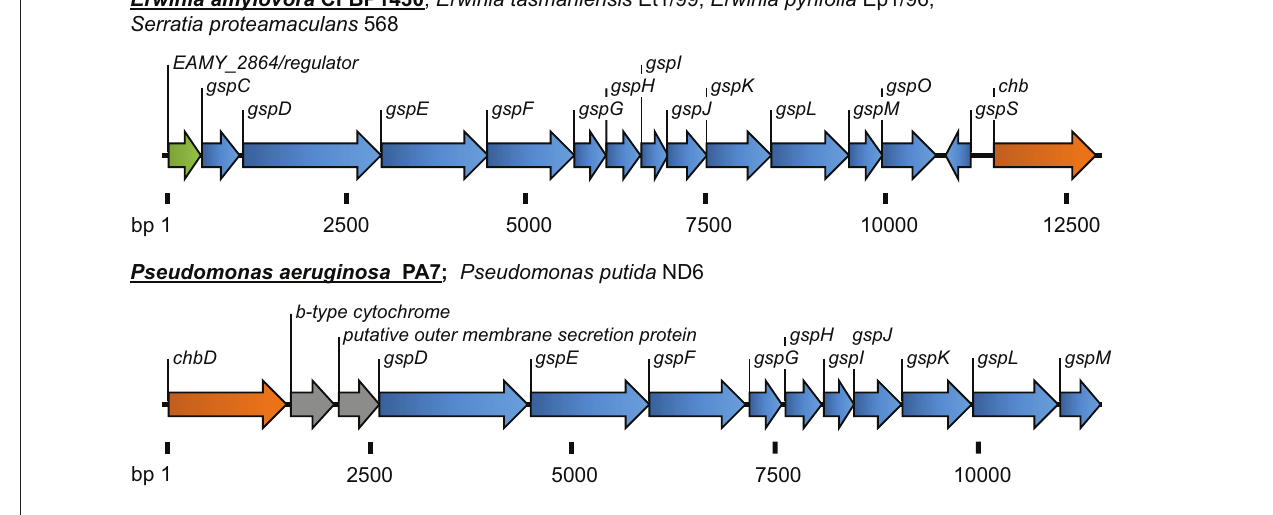
FIGURE 2 | Overview of the T2SSs Yts2 and Yts1 in Y. enterocolitica . For comparison, T2SSs of Erwinia, Serratia , and Pseudomonas species are depicted. The size of gene clusters is indicated as basepairs (bp). Coloration